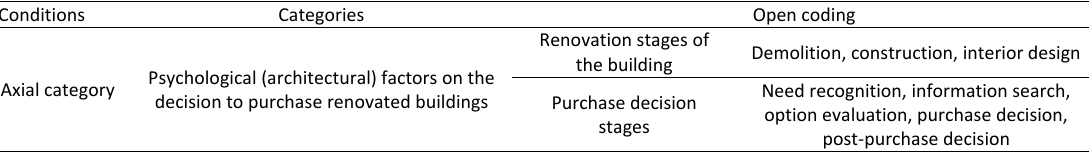
Table 3: Core coding in categories and concepts related to the core category